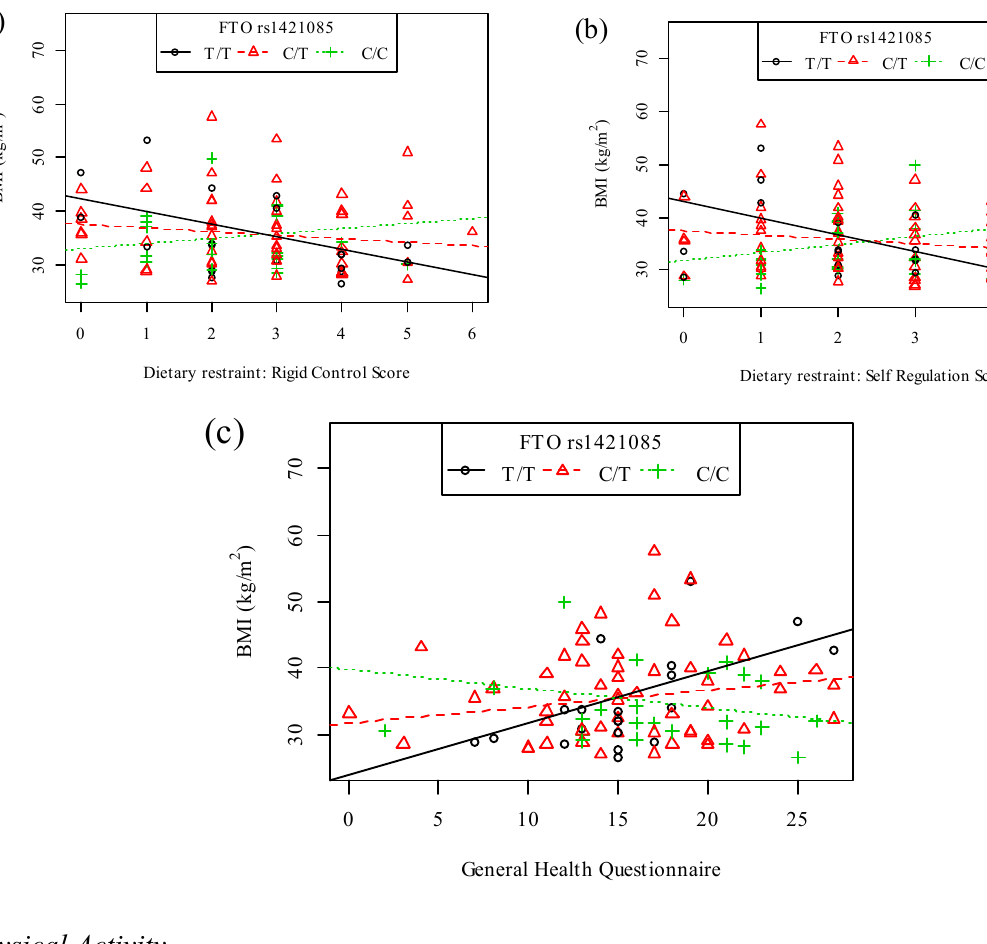
Figure 1. Interactions between the FTO rs1421085 polymorphism and eating behavior or psychological health on BMI. Plots of BMI against ( a ) rigid control score ( p = 0.0290); ( b ) attitude to self-regulation score ( p = 0.0095) and ( c ) General Health Questionnaire score ( p = 0.0085). Symbols represent all individual observed values for males and females and regression lines show the expected relationships for a female, from the additive allelic model, for each genotype of the FTO rs1421085